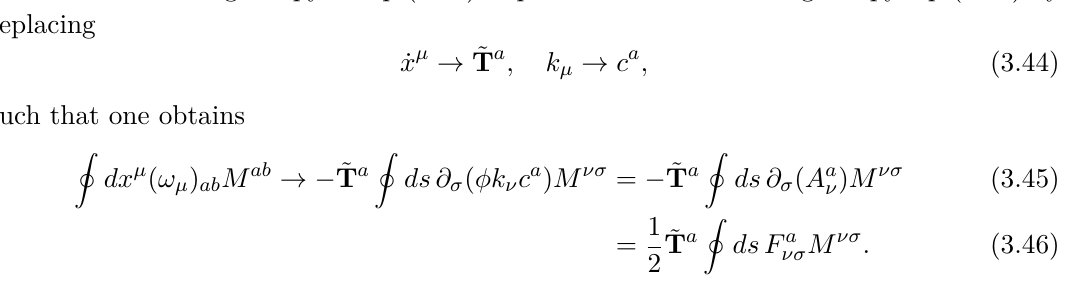
Table 1 . Holonomy operators in gauge and gravity theories, and their single/double copies. The Kerr-Schild single copy of eq. (3.29) implies that we should single copy eq. (3.43)